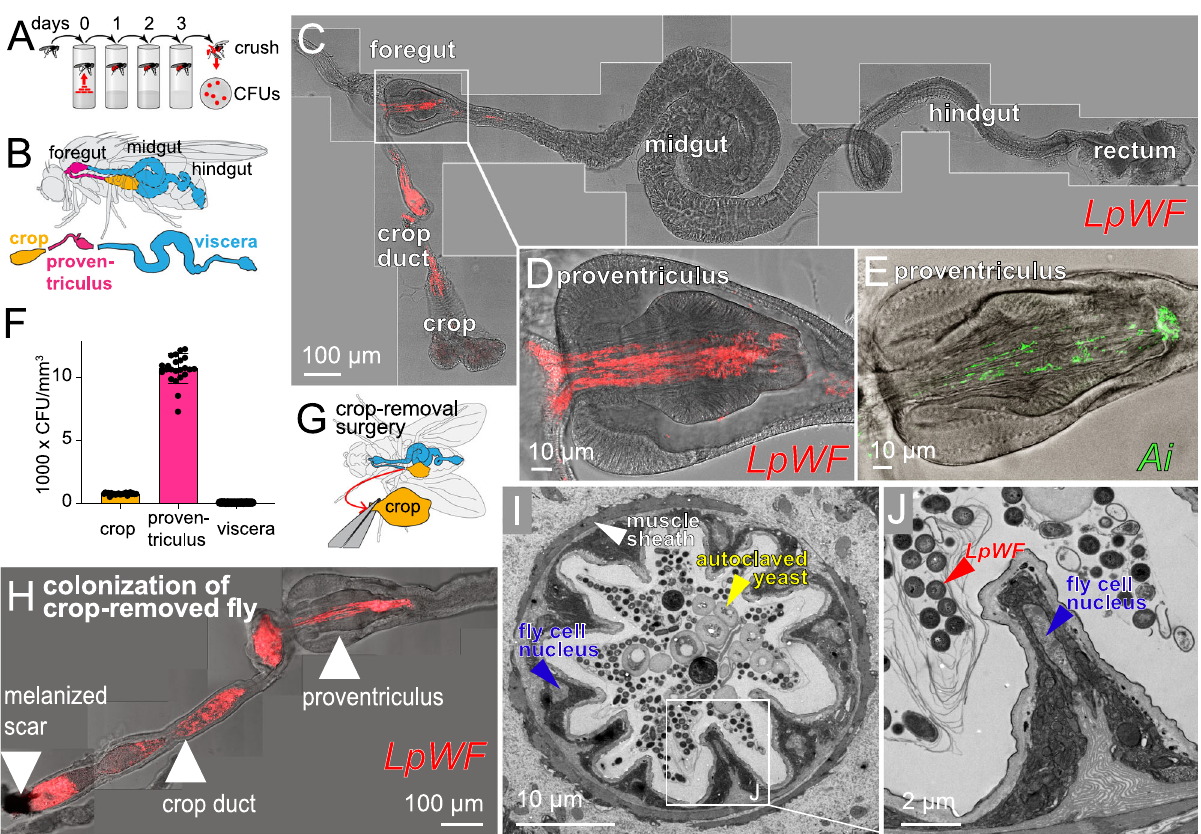
Fig. 1 | LpWF stablycolonizes the fl y gutwithspatial speci fi city. A Colonization assayschematicwithinitialdosingonday0andserialtransferstosterilefooddaily for 3 days before analysis. B Gut diagram. C Microscopy of LpWF -mCherry colo- nization in a whole gut after clearing transient cells shows a speci fi c colonization zone in the foregut. Shown is a maximum-intensity z -projection. D The proven- triculusisamajorsiteof LpWF colonization. E Ai colonizationisalso speci fi ctothe proventriculuslumenandcropduct(seealsoFig.S2). F CFUdensitiesfromregions